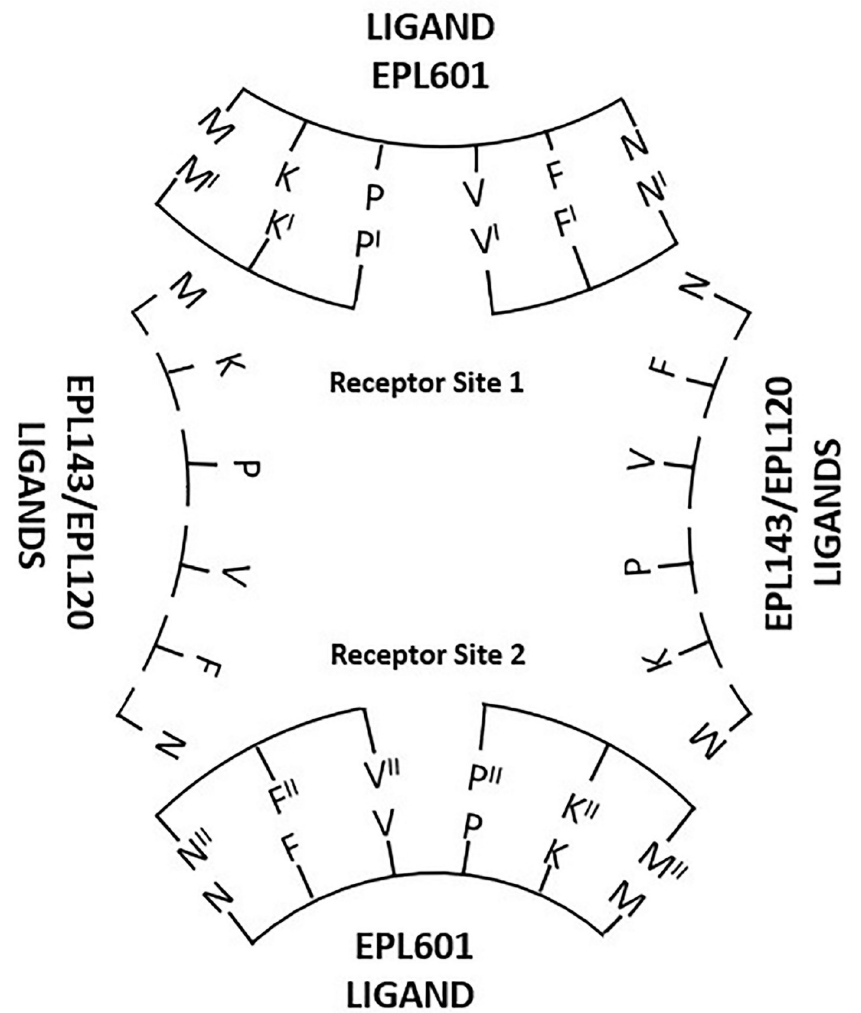
Fig 10. Dimeric receptor conceptualisation. A 6mer peptide (EPL601), a 14mer (EPL143) and a 20mer (EPL120) can be brought into a single interpretative scheme of bioactivity by positing a receptor comprising (at least) two binding sites, in antiparallel orientation, each site having two tri-residue modules. Ligand bimodular residues (MKP & VFN) actual, receptor residues (with superscripts)